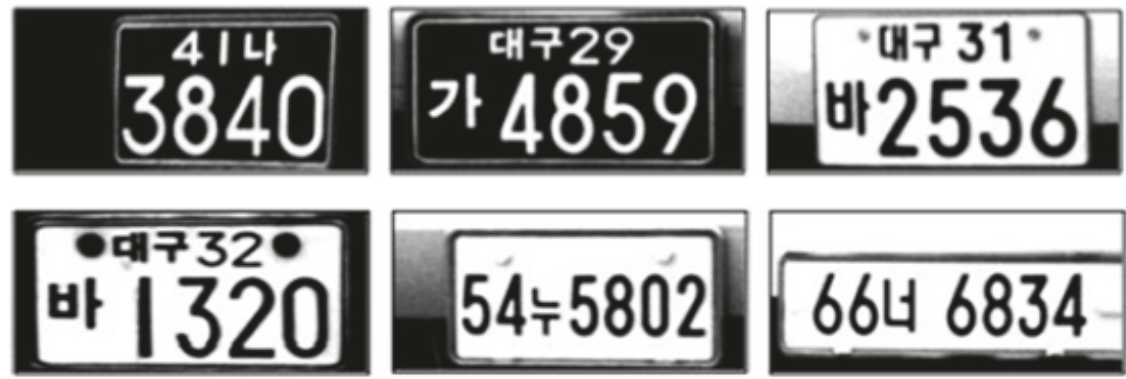
Figure 1: Six different types of Korean vehicle